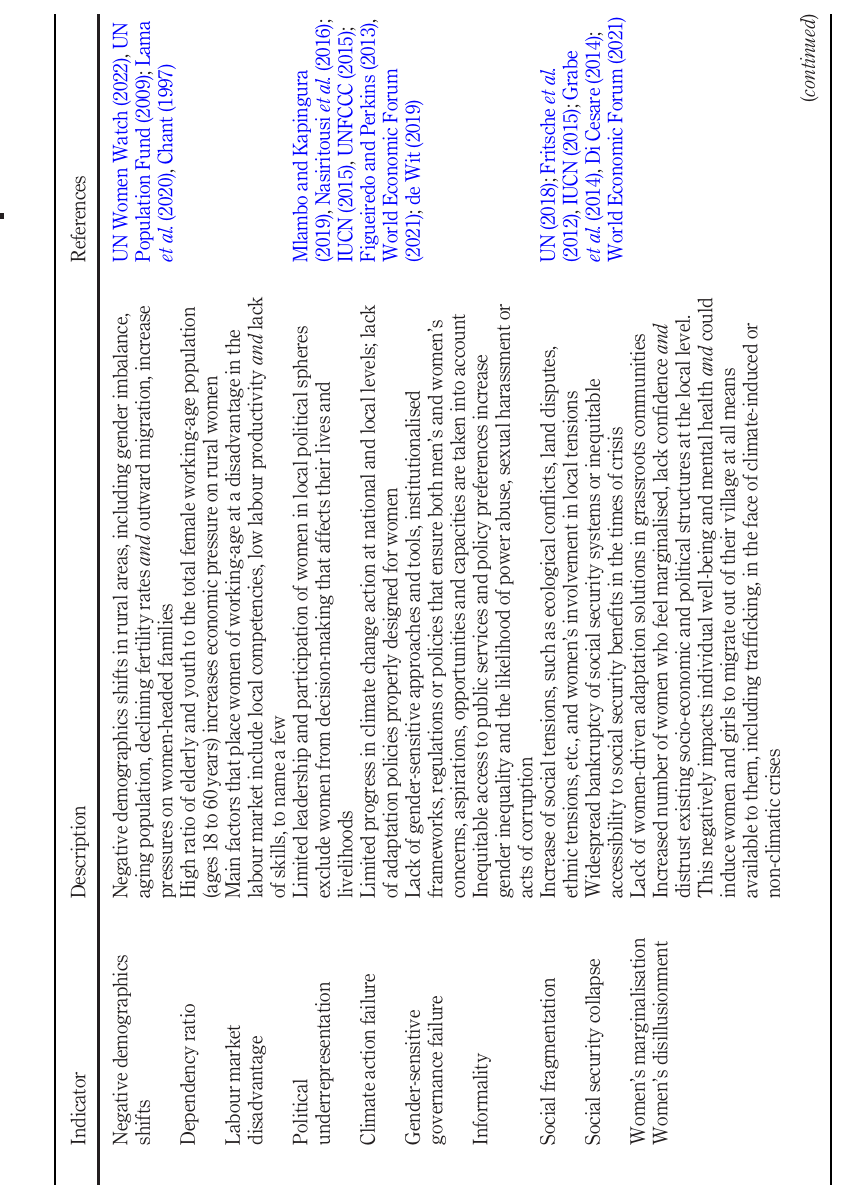
Table 3. Security and political risk categories and